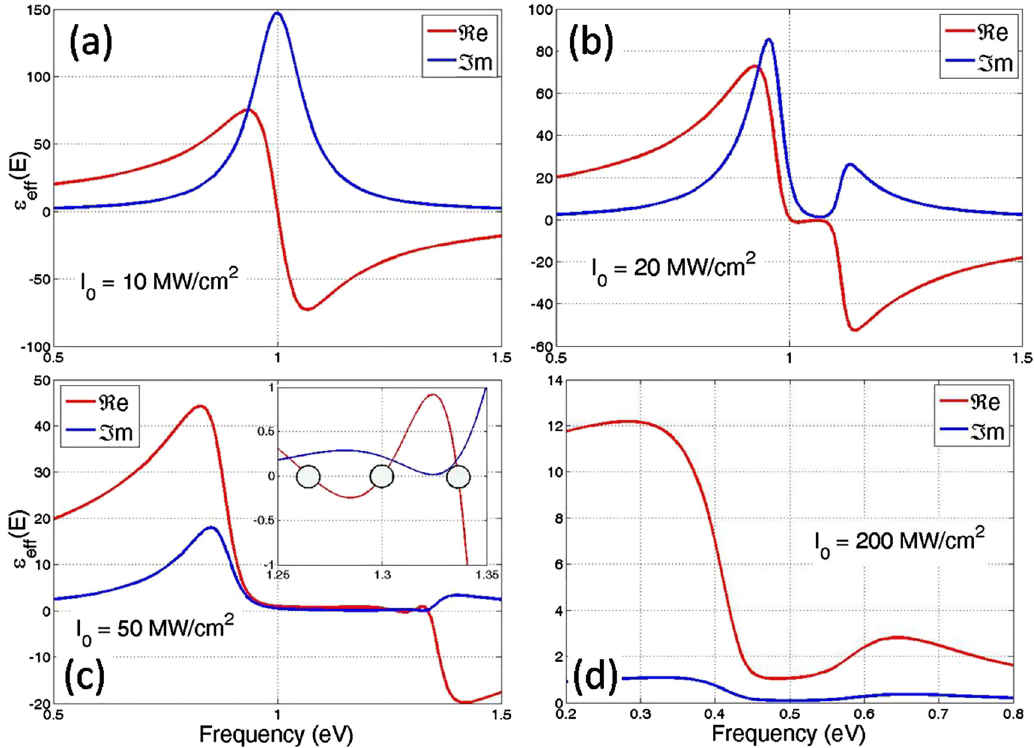
Figure 3: Spectra of the real and imaginary parts of the effective dielectric